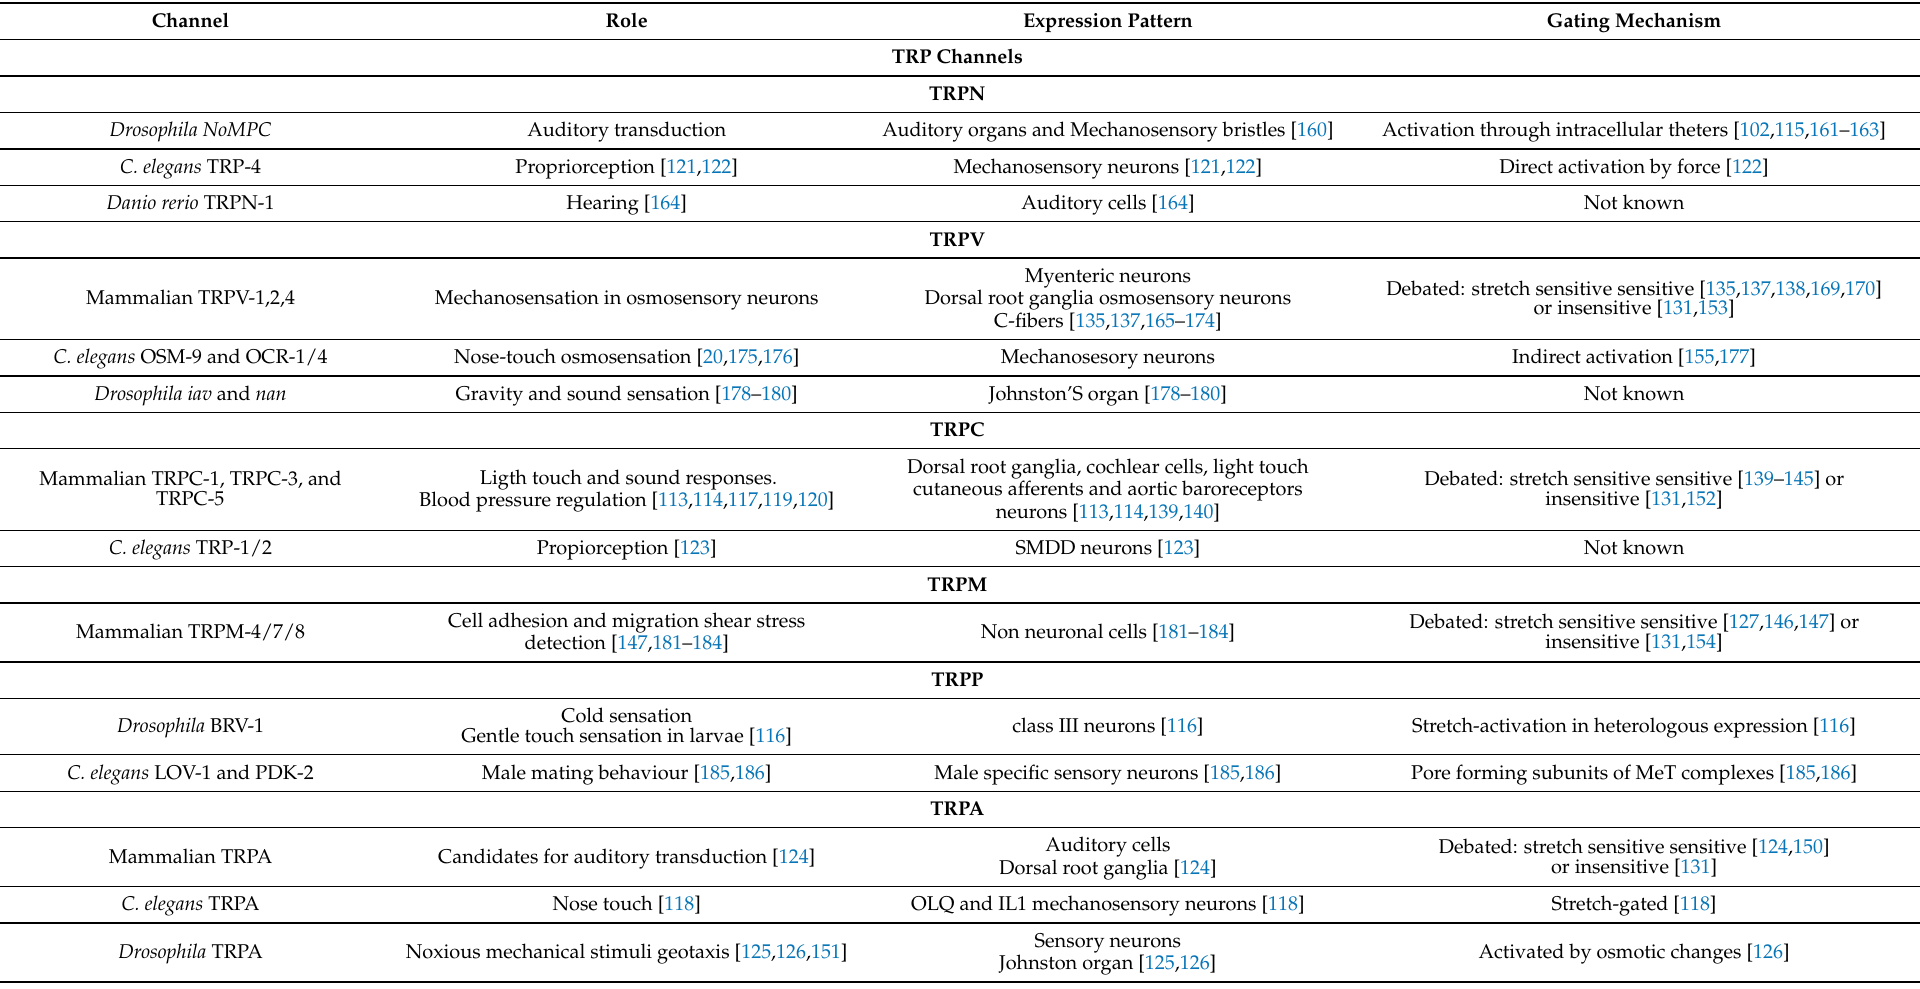
Table 2. List of mechanosensitive TRP channels expressed in